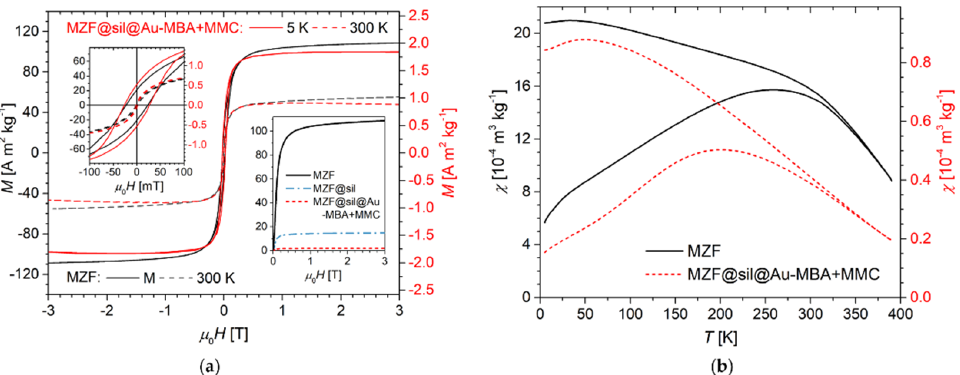
Figure 3. Magnetic properties: ( a ) Hysteresis loops of bare ferrite nanoparticles (left axis) and final gold nanoshells (right axis) at temperatures of 5 K and 300 K (the scale of the right axis is adjusted so that the low-temperature curves of both samples coincide at μ 0 H = 0.3 T). The low-field details of magnetization curves are depicted in the upper left inset. The lower right inset shows the virgin curves for bare ferrite nanoparticles, silica-coated intermediate, and final gold nanoshells at 5 K. ( b ) ZFC-FC mass susceptibilities, χ ZFC and χ FC , of bare ferrite nanoparticles (left axis) and gold nanoshells (right axis) in the magnetic field of 2